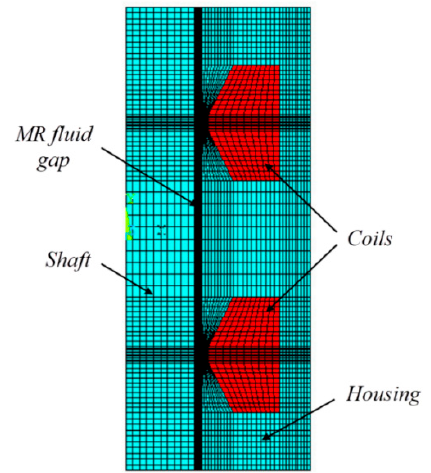
Figure 9. Finite element model of the MR damping part.